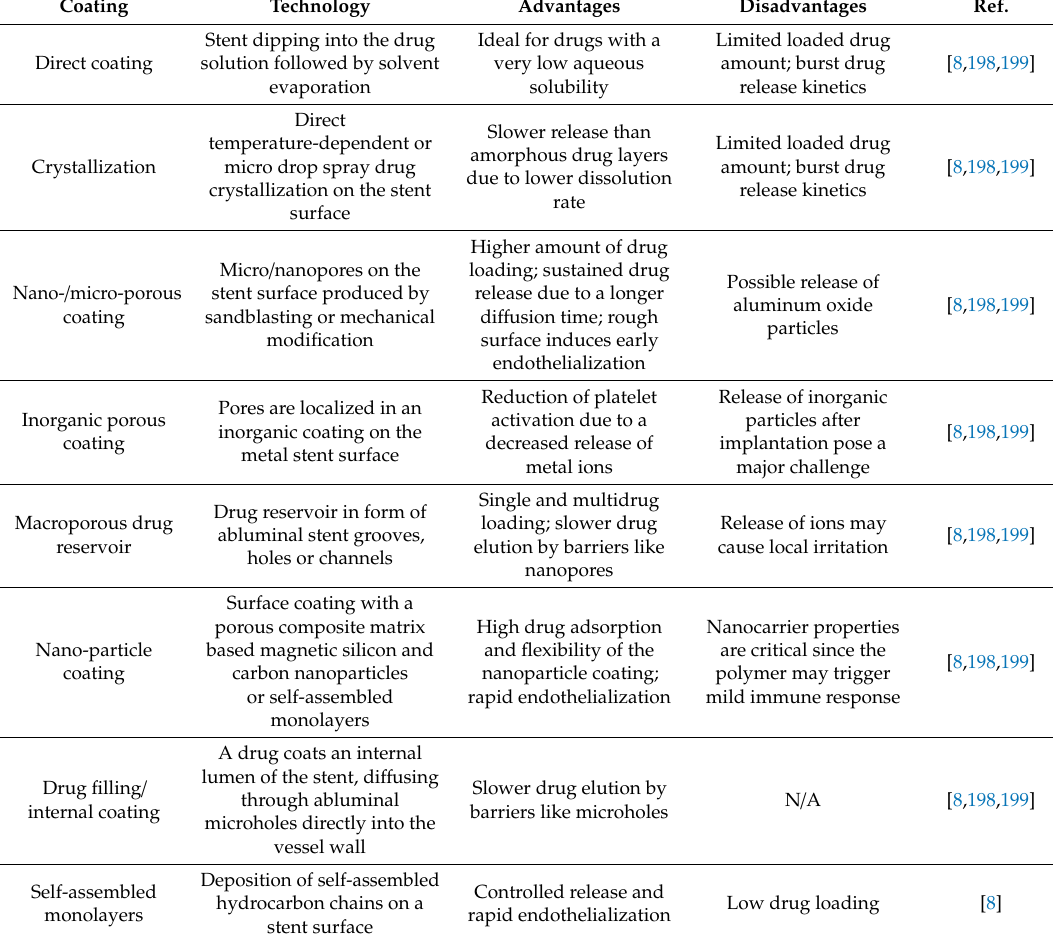
Table 4. Comparison of various surface modification techniques used in drug eluting stents (DES).